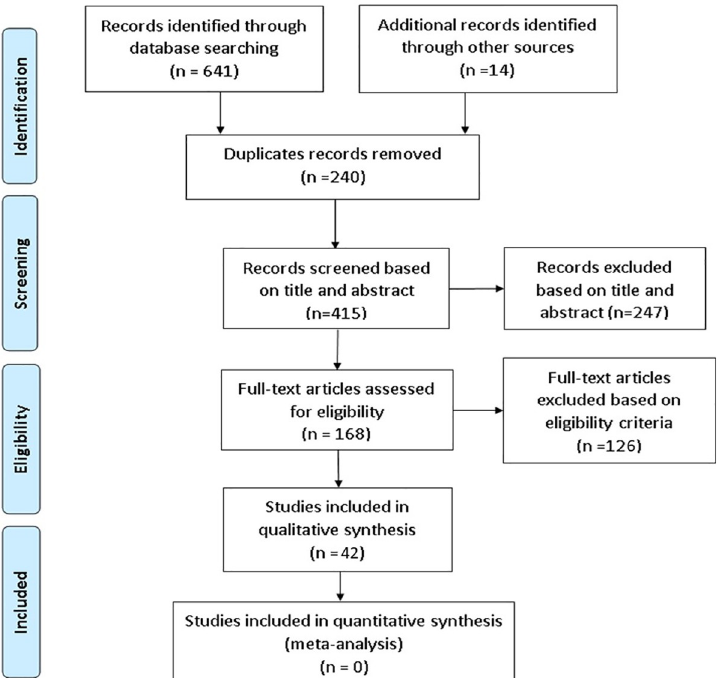
Fig 1. Flow diagram of the literature search according to the PRISMA